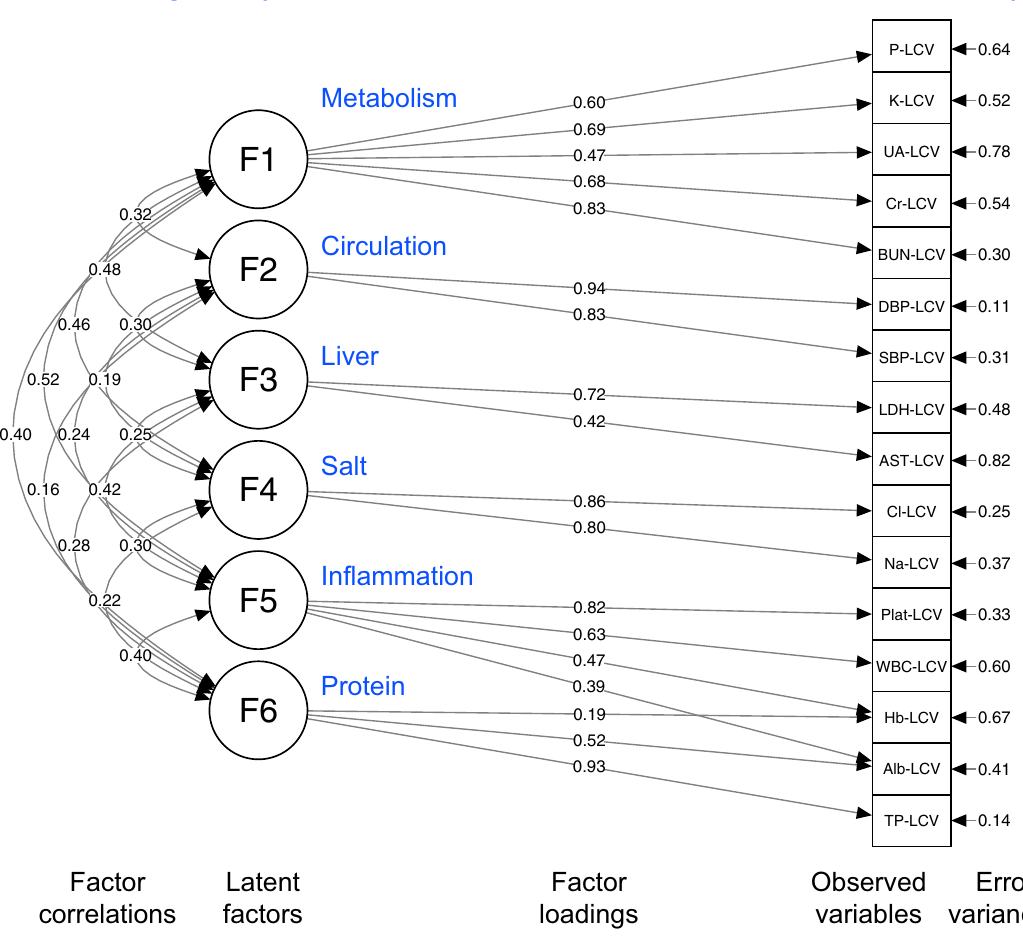
Figure 4. Path diagram for the six-factor CFA model. The model illustrates the associations among regulatory domains (paths with double headed arrows) and between each domain and the observed biomarker variabilities (paths with single-headed arrow). The values are standardized path